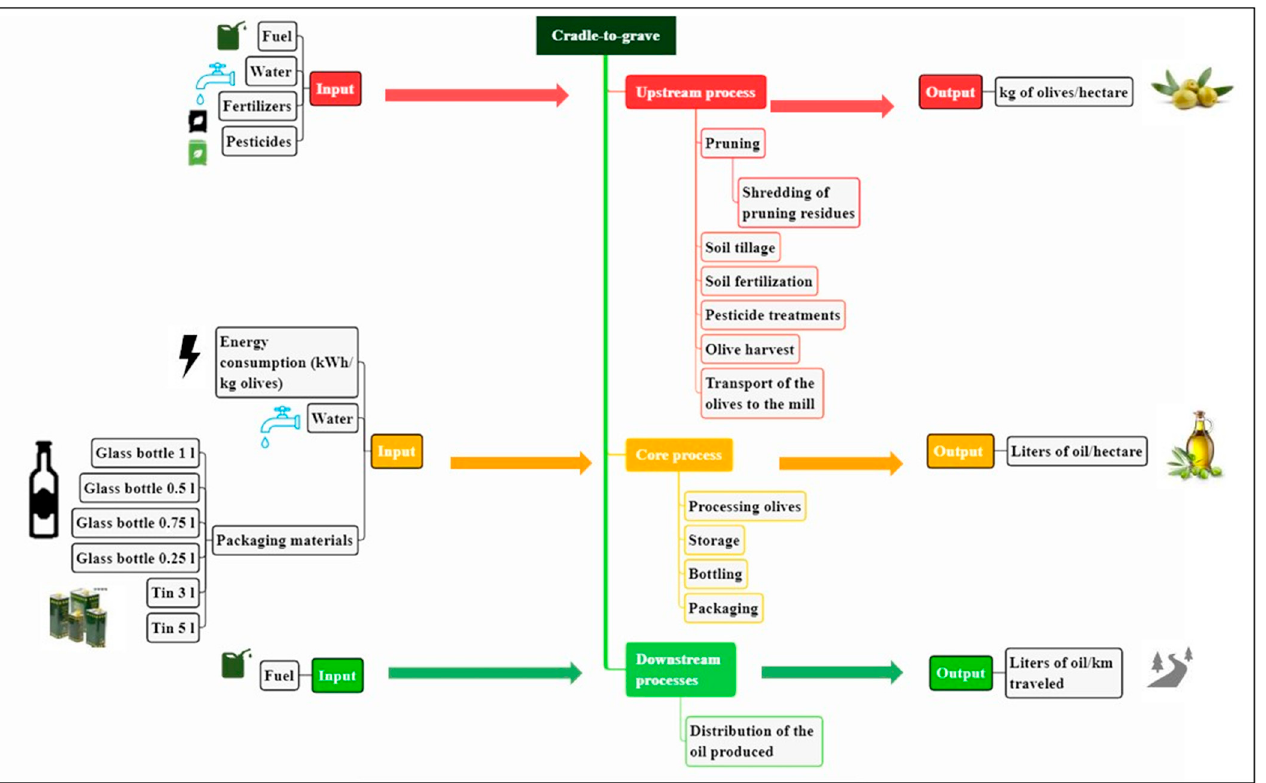
Figure 1. System boundaries for all analyses: life cycle assessment (LCA), Water footprint (WF), Life Cycle Costing (LCC), Social Life Cycle Assessment (SLCA).